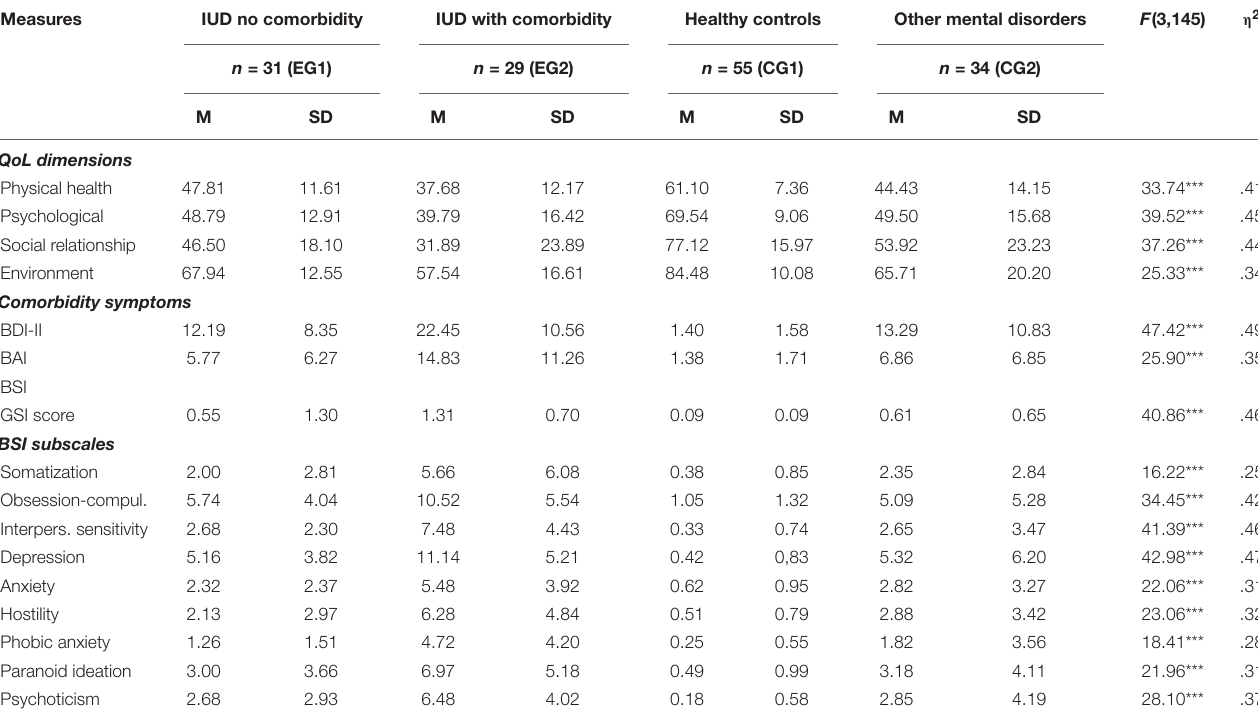
Mean parameter values for each of the analyses are shown for IUD patients (n = 60) and healthy controls (n = 55), as well as the results of bootstrapped t tests (assuming unequal variance) comparing the QoL domains. TABLE 3 | Means, standard deviations, and one-way analyses of variance in quality of life (QoL) and comorbidity: comparison of study groups. Measures IUD no